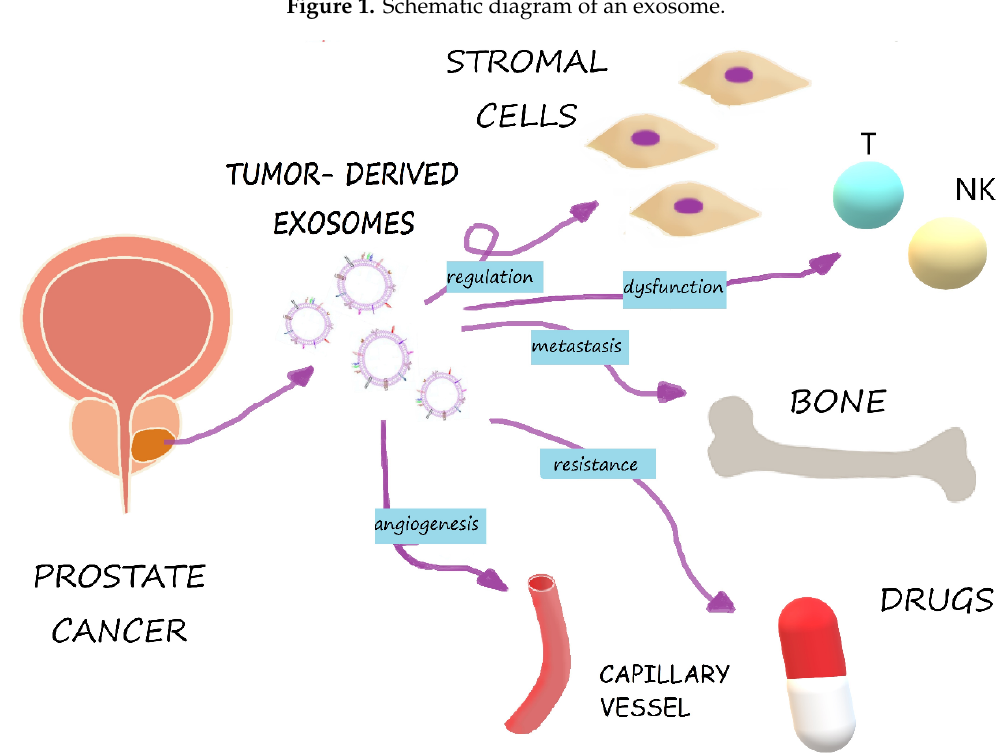
Figure 2. Role of prostate cell-derived exosomes in cancer progression. Exosomes regulate stromal cells, impair immune cells and alter the microenvironment, which could lead to tumor growth and metastasis. Exosomes are also responsible for drug resistance.